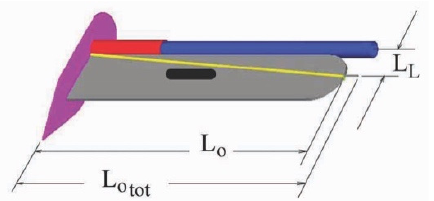
Figure 9. Geometry Definitions of Flexspar Actuator Element.